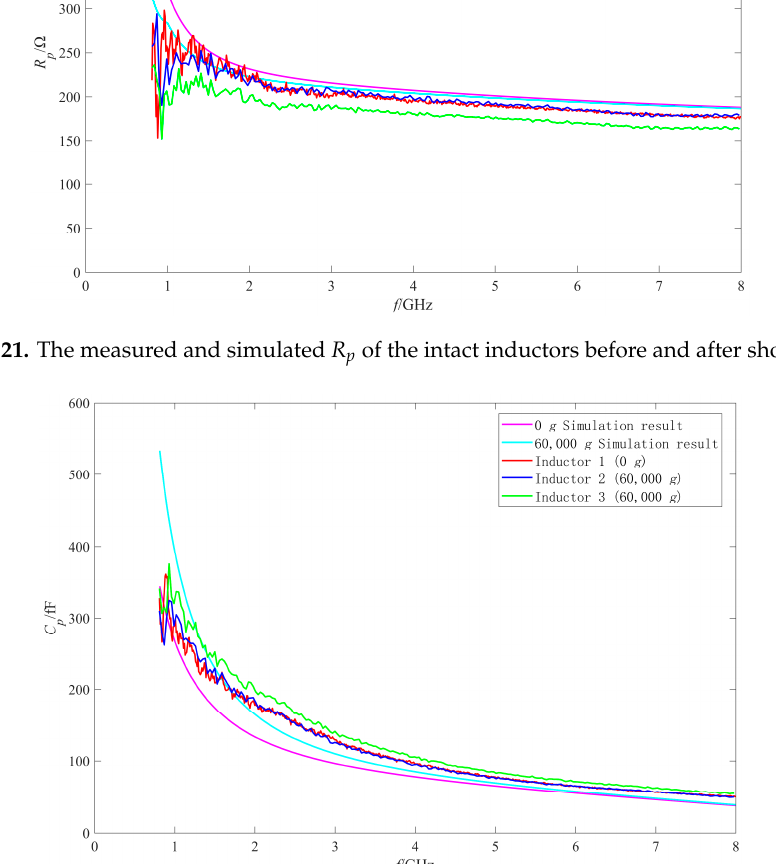
Figure 22. The measured and simulated 𝐶 (cid:3043) of the intact inductors before and after shock test.